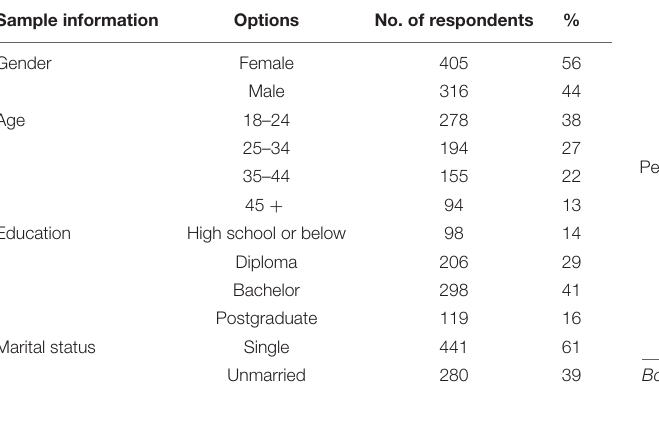
TABLE 3 | The demographic information of the sample. Sample information